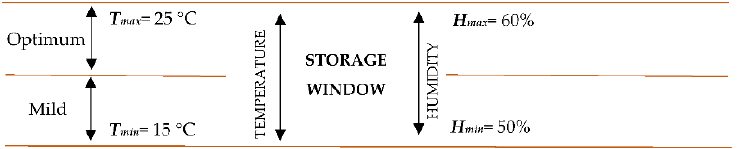
Figure 9. Storage window for temperature and humidity.